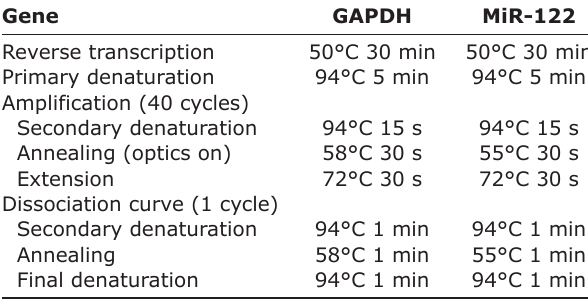
Table-2: Cycling conditions for SYBR Green Real-time PCR according to Quantitect SYBR Green PCR